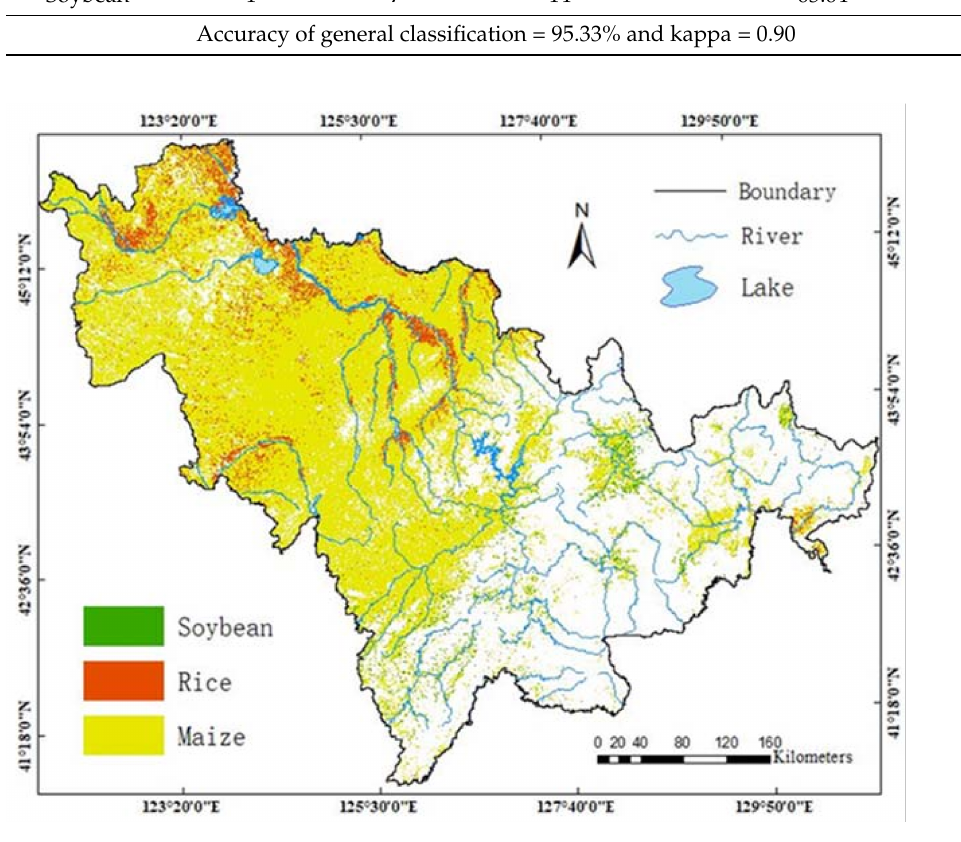
Figure 4. Existing maps of maize, rice, and